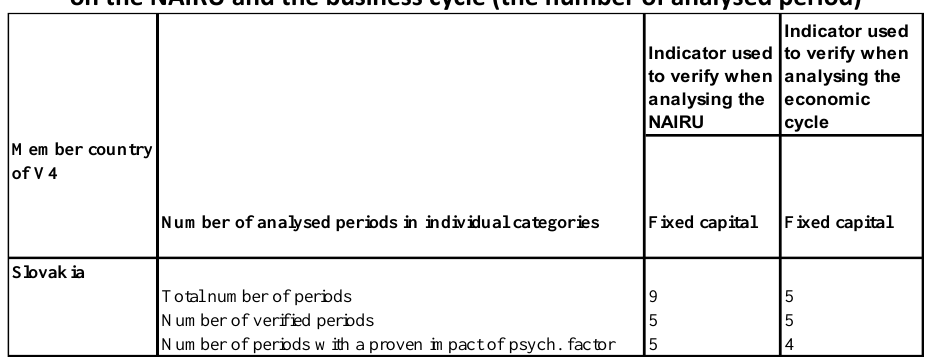
Source: Own calculation based on data from the OECD and the